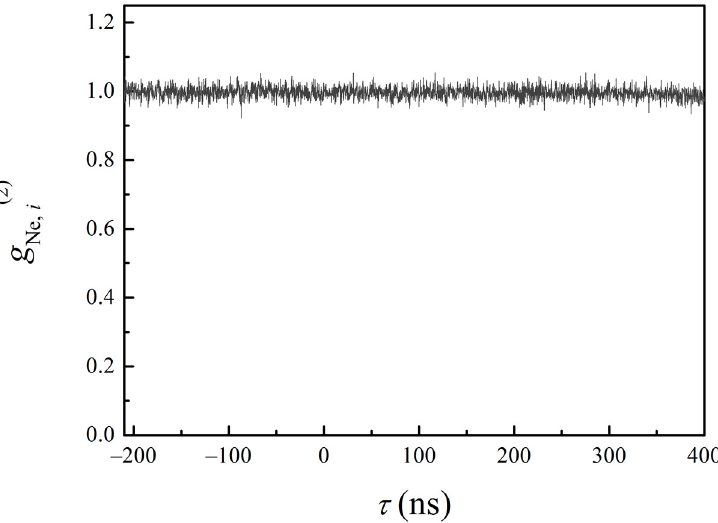
Figure 5. The intensity cross-correlation function between a Ne lamp and a single mode of the laser studied.